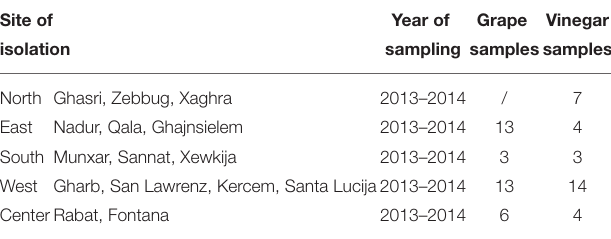
TABLE 1 | Site of grape and vinegar sampling in the Island of Gozo,